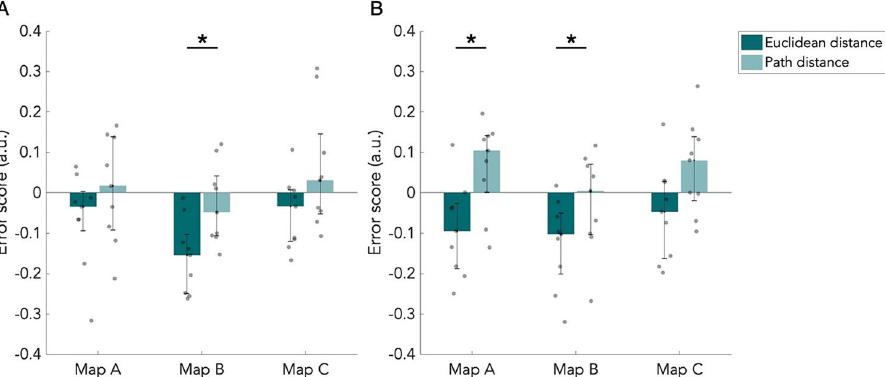
Figure 4. Error scores of the distance estimation task. Median error score of estimated distances, corrected for the maximum error possible. Results are shown for both Euclidean and path distance for all three maps. Error bars indicate the 25th and 75th percentiles. Grey dots are individual data points. ( A ) Results of the haptic group (n = 9). ( B ) Results of the visuo-haptic group (n = 9). * p < 0.05, corrected for multiple